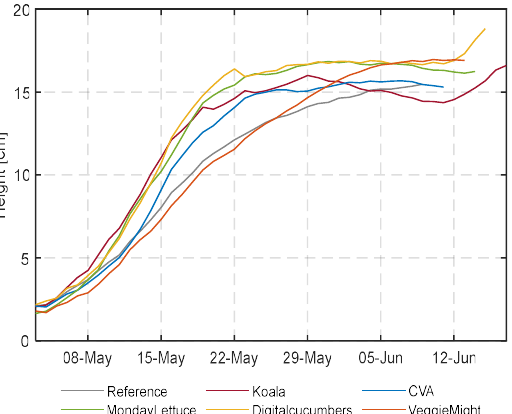
Figure 16. Daily calculated lettuce height from RealSense camera images in all compartments during the cultivation start.